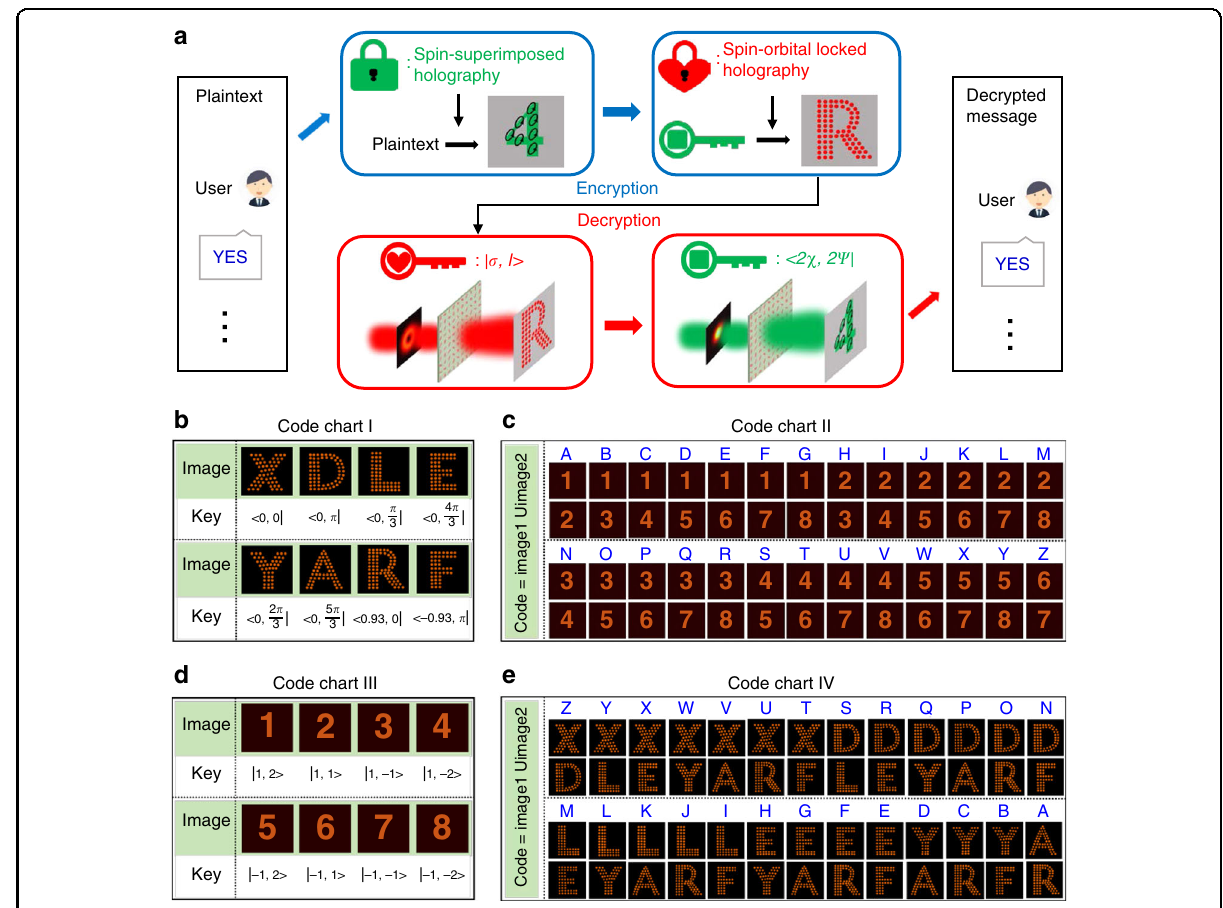
Fig. 4 Schematic illustration of the optical nested encryption and demonstration of the code charts. a Conceptual illustration of the optical nested encryption scheme based on the AM meta-hologram. The optical information is successively encrypted by the two kinds of independent holography, which are represented by a red lock and a green lock, respectively. b , d Demonstration of code chart I and III, with the SOL and SS holographic images are translated to constitute keys for next decryption, respectively. c , e Demonstration of code chart II and IV, where the alphabet from A to Z are encoded. The coding rule is that each letter corresponds to a union set of two holographic